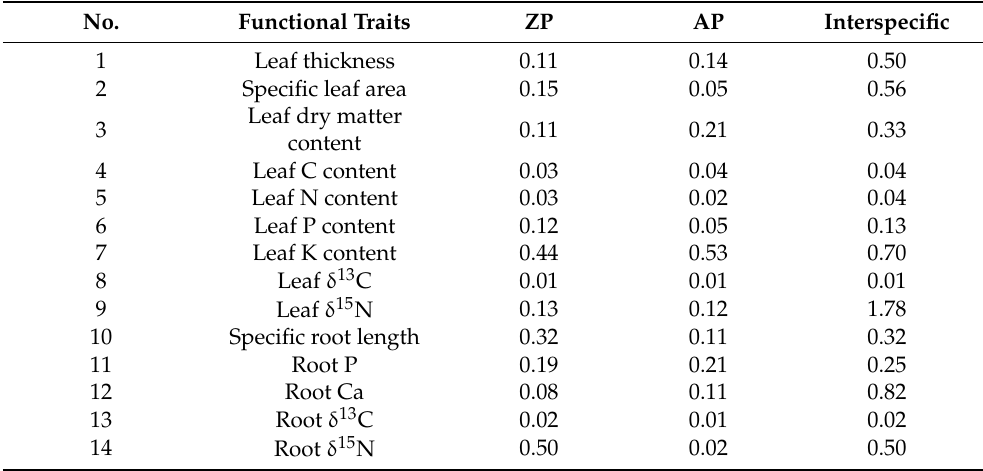
Table 4. Sensitivity analysis of changes in main functional traits.